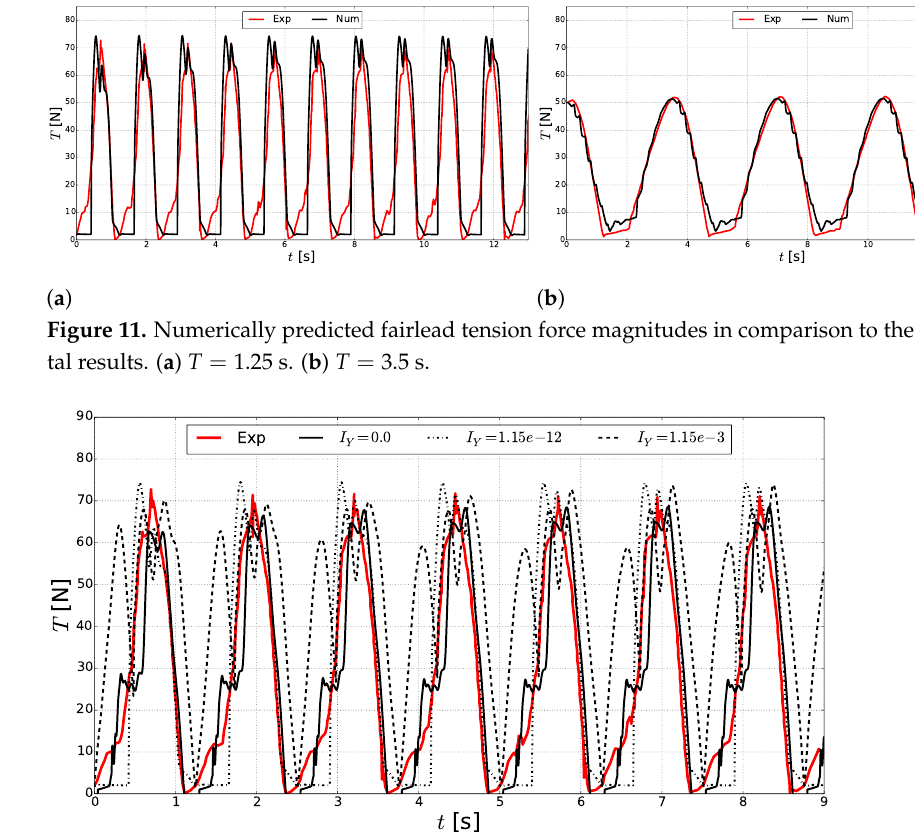
Figure 12. Numerically predicted fairlead tension force magnitudes for different bending stiffnesses in comparison to the experimental results for T = 1.25